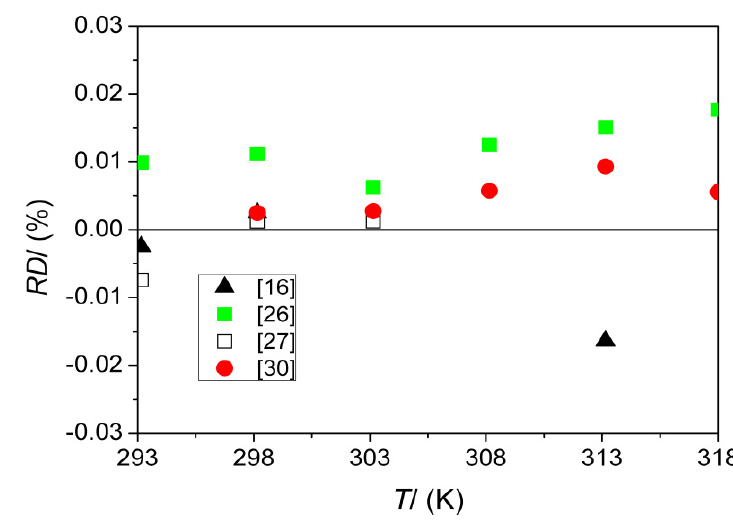
Figure 2. Comparison of the density of 1-butanol as a function of temperature under atmospheric pressure obtained in this work ( ρ this work ) with the literature values ( ρ lit ) [16,26,27,30] presented as relative deviations RD s ( RD /% = 100·( ρ this work − ρ lit )/ ρ this work ).